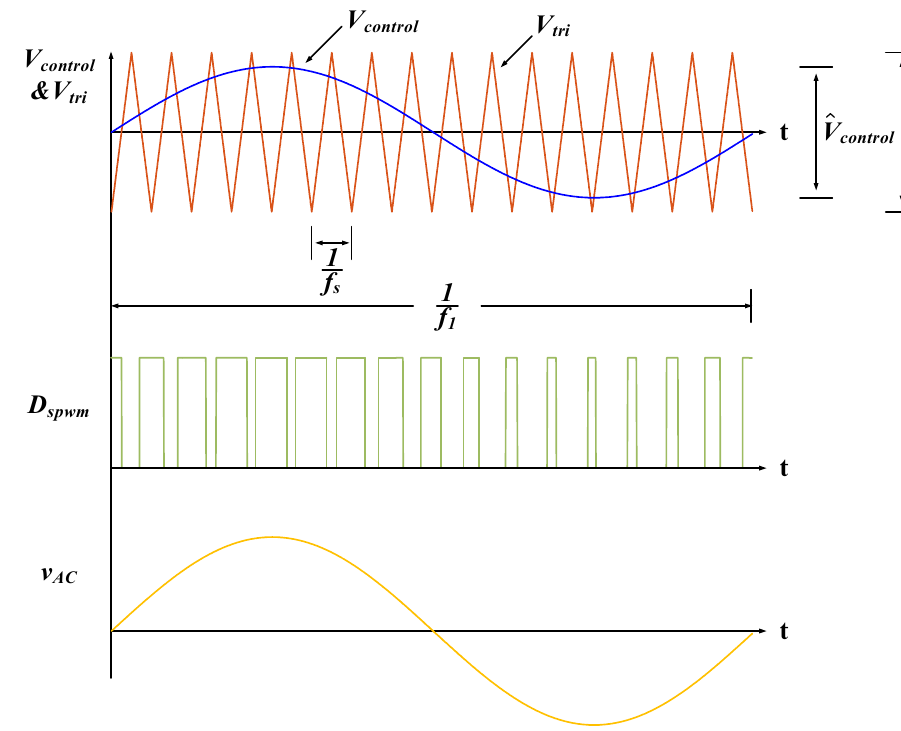
Figure 8. The relationships among the control signal, duty ratio, and AC output v AC in buck inverters with traditional SPWM control.